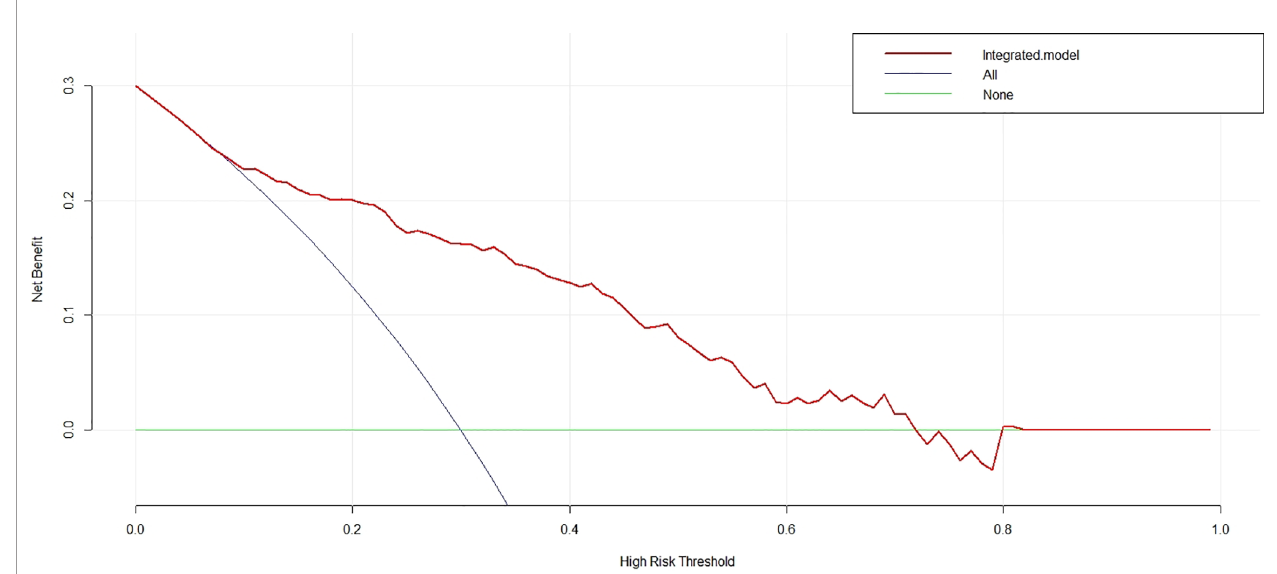
FIGURE 5 | Decision curve analysis for the nomogram. With the threshold probabilities >10%, using the nomogram to predict the uncommon epidermal growth factor receptor status added more bene fi t than using the treat-all scheme or the treat-none